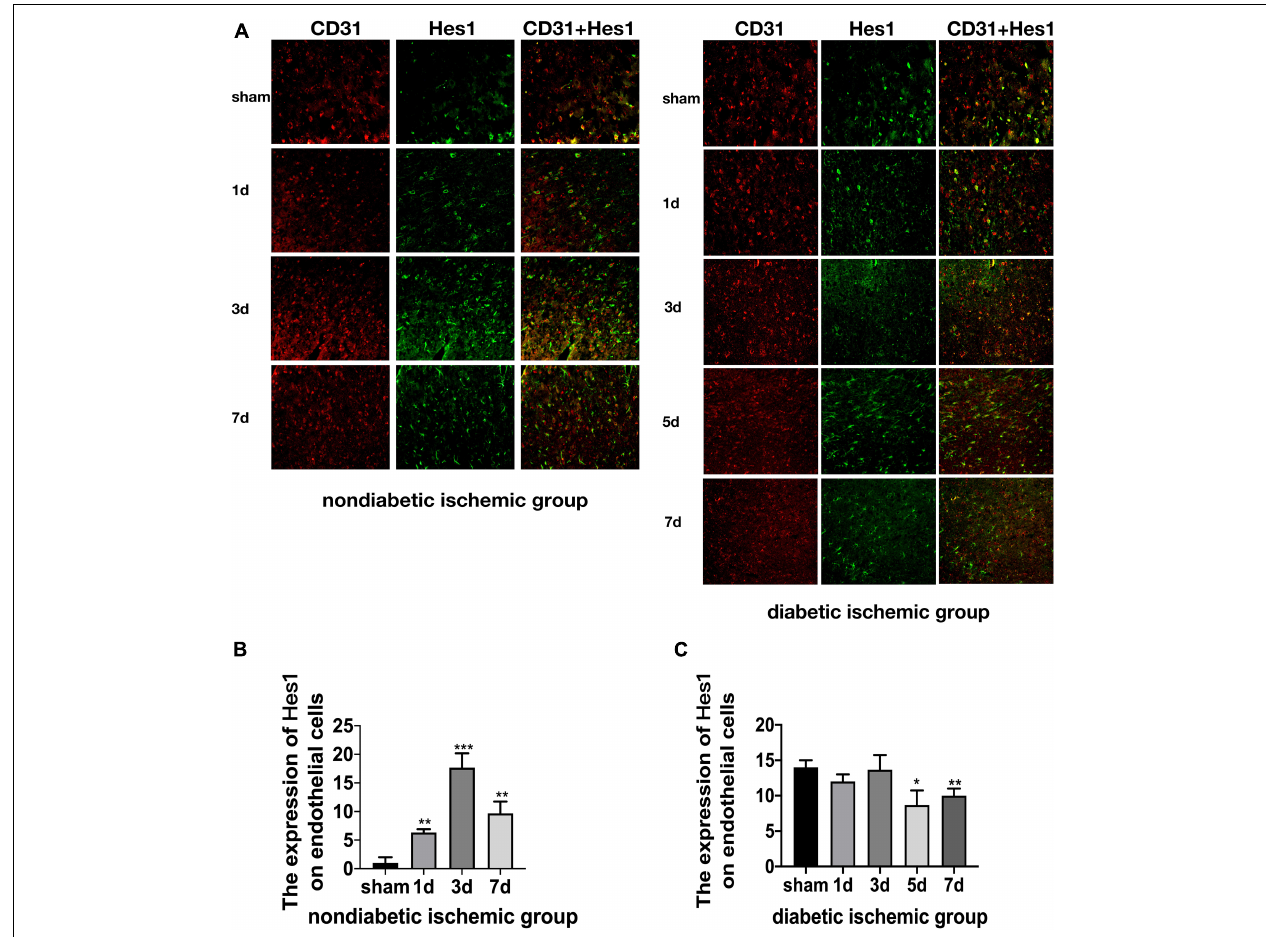
FIGURE 7 | Suppressed Jagged1-Notch1 signaling after acute ischemic stroke in T2DM. (A–C) The expression of Hes1 and CD31 was assessed by immunofluorescence staining in ischemic penumbra (Magnification × 200. Scale bar = 100 µ m) and the positive cells of Hes1 and CD31 were calculated ( n = 3 per group). * p < 0.05 vs. sham group, ** p < 0.01 vs. sham group, *** p < 0.001 vs. sham